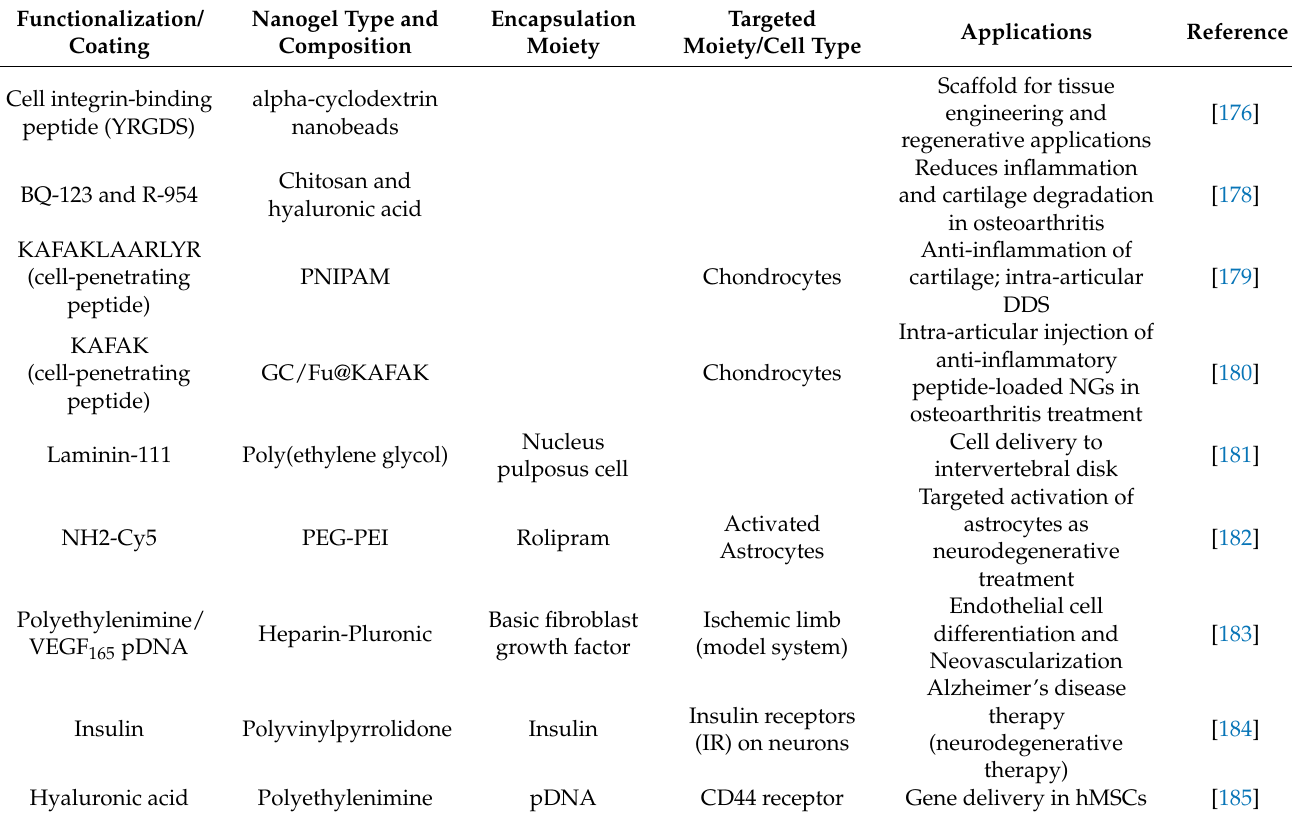
Table 5. Functionalized NGs-based approaches in tissue engineering and regenerative